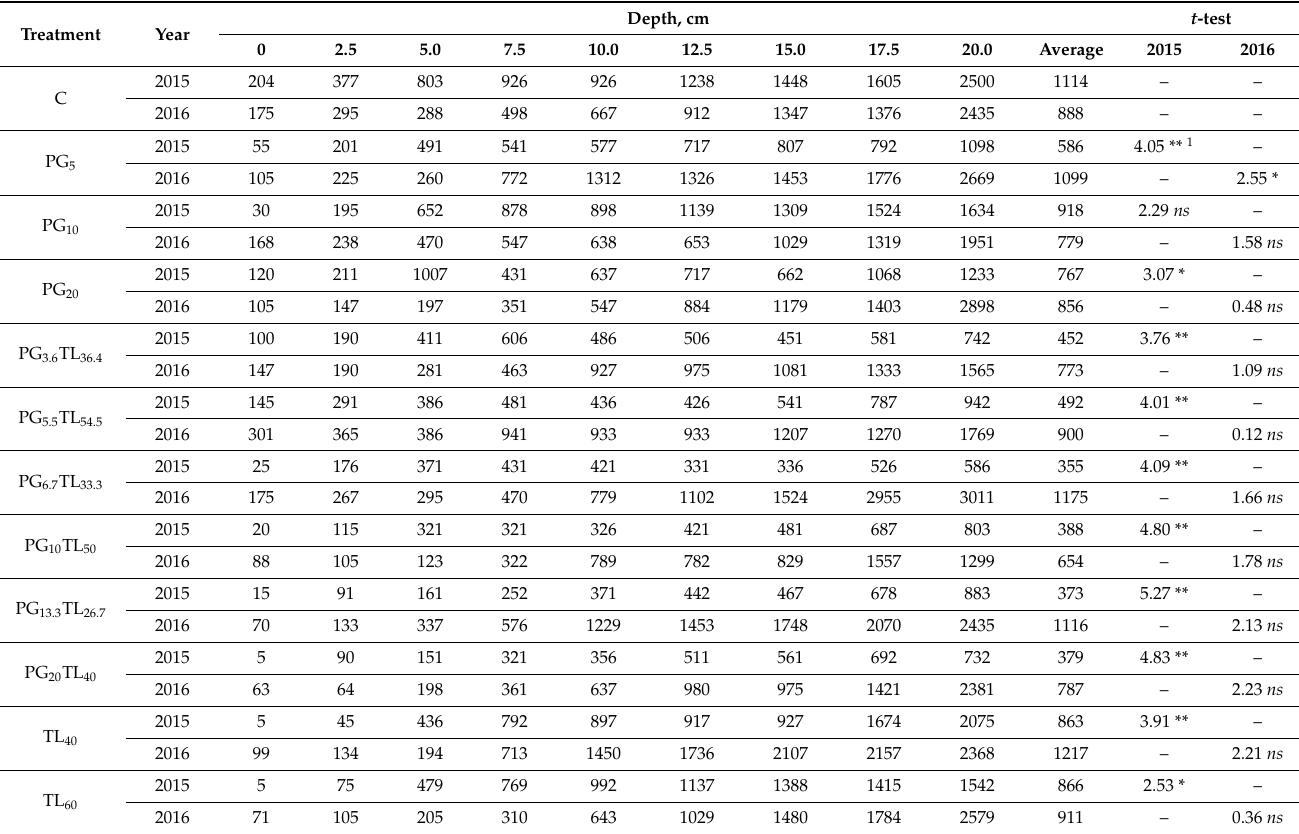
Table 3. Effect of treatments and years on the soil penetration resistance, kPa.